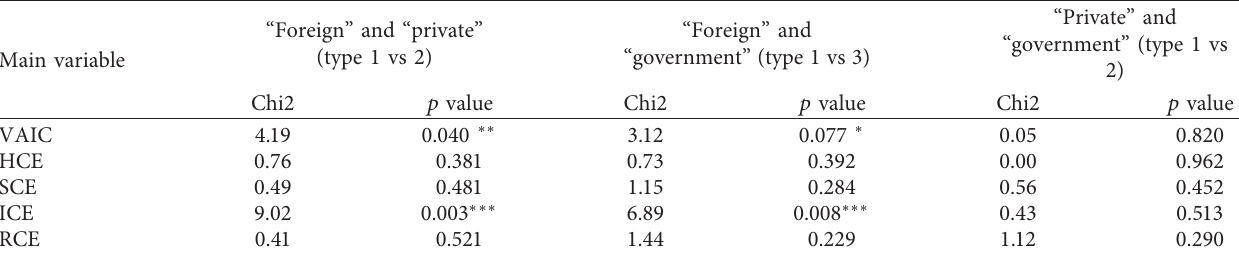
Table 11: Robustness check results of SUR-test of group (Types 1 vs 2, 1 vs 3, and 2 vs 3) coefficient